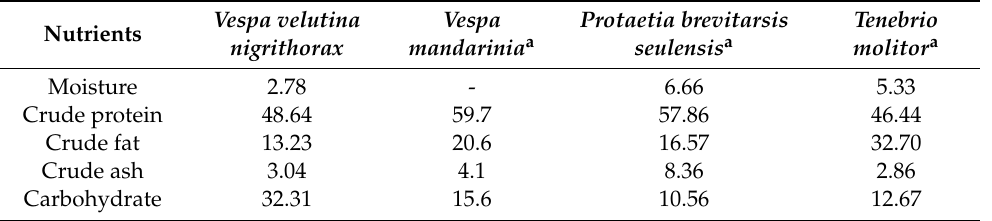
seulensis and T. molitor larvae (g / 100